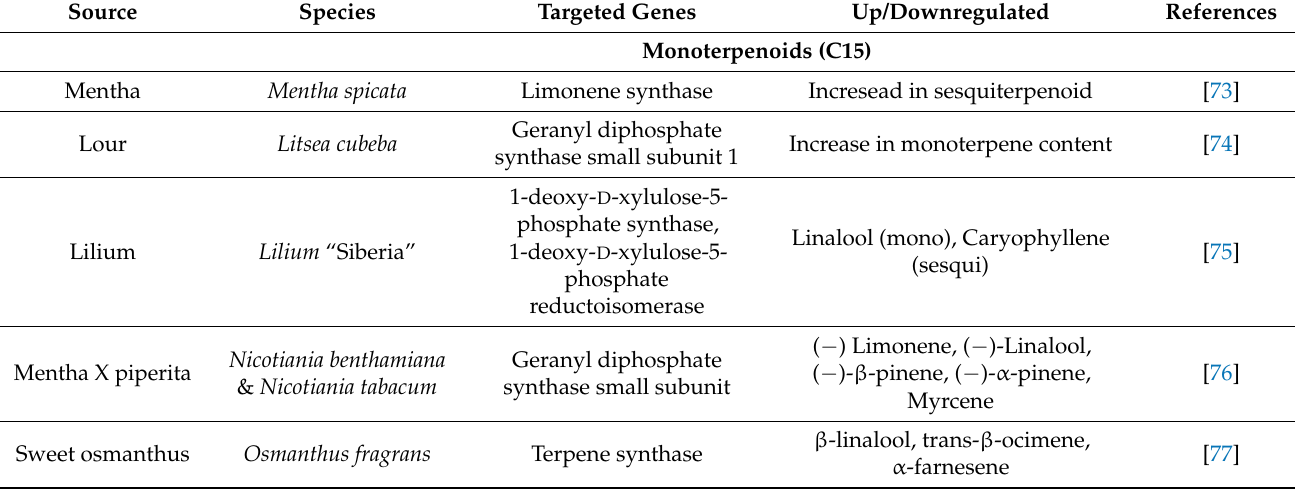
Table 3. Reports on the metabolic engineering of monoterpenoids, sesquiterpenoid targeted genes, their derivatives, as well as their precursors and upregulated metabolites are